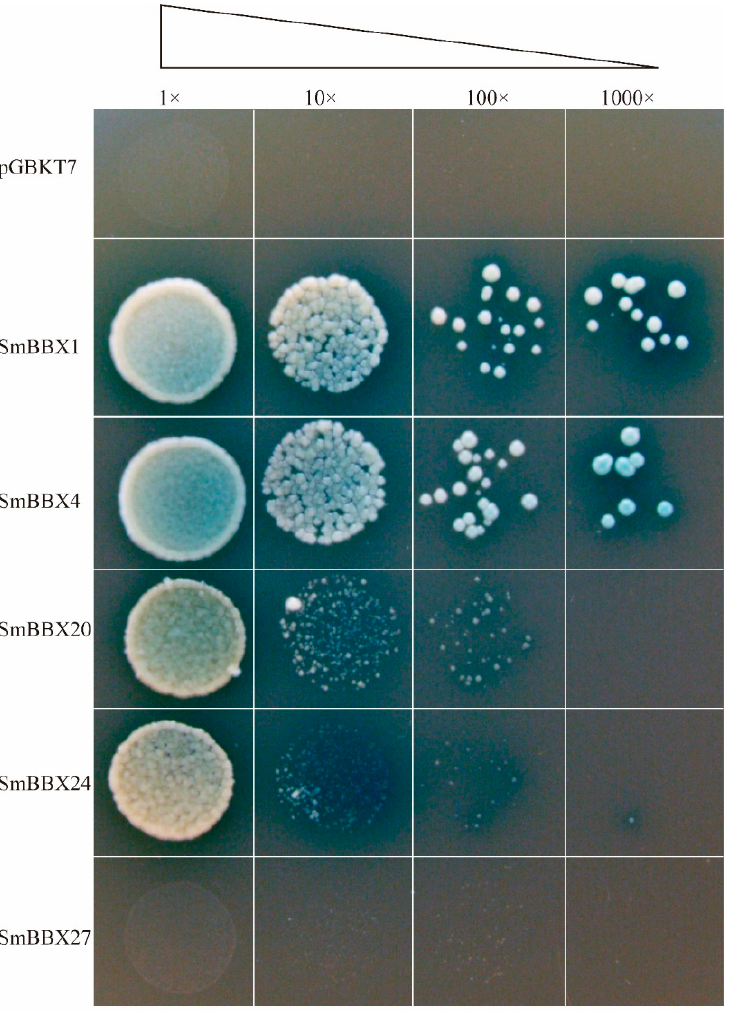
Figure 8. Transcriptional activities of SmBBX TFs in yeast. SD/Trp-/His-/Ade-medium containing 5 mg/mL X- α -gal. The empty pGBKT7 is the negative control. Concentration gradients: 1×, 10×, 100×, 1000×.